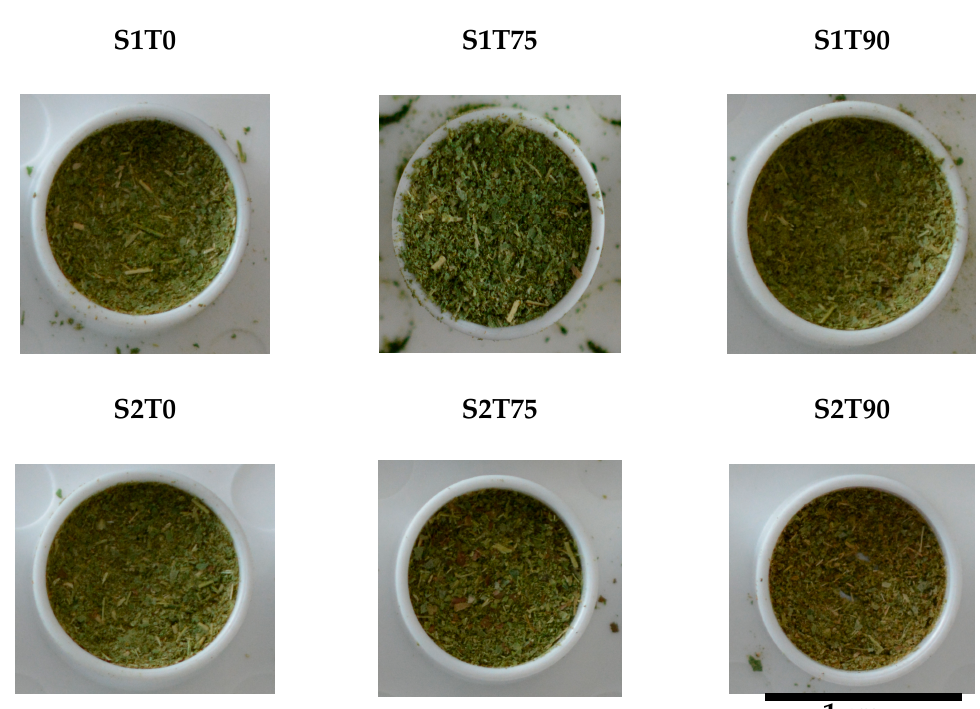
Figure 2. Representative image of S1 and S2 samples analysed by FTIR, µ-XRF and HSI.